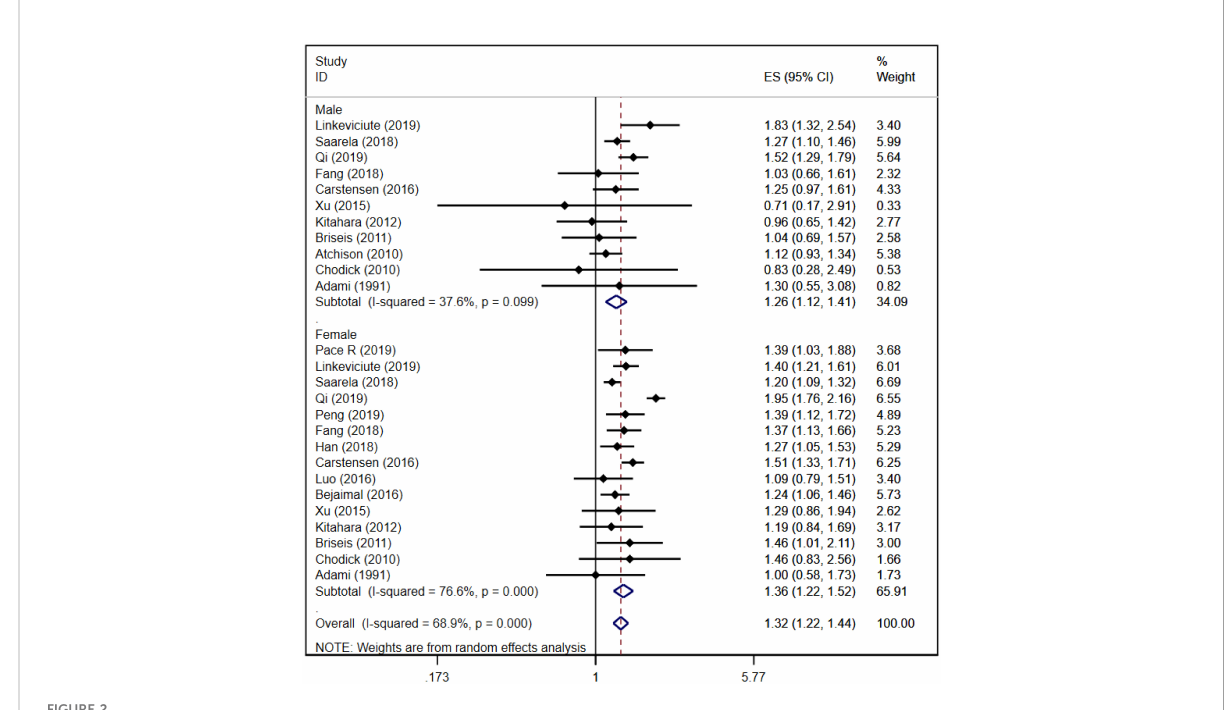
FIGURE 2 Forest plots of sex-speci fi c thyroid cancer risk in any type of